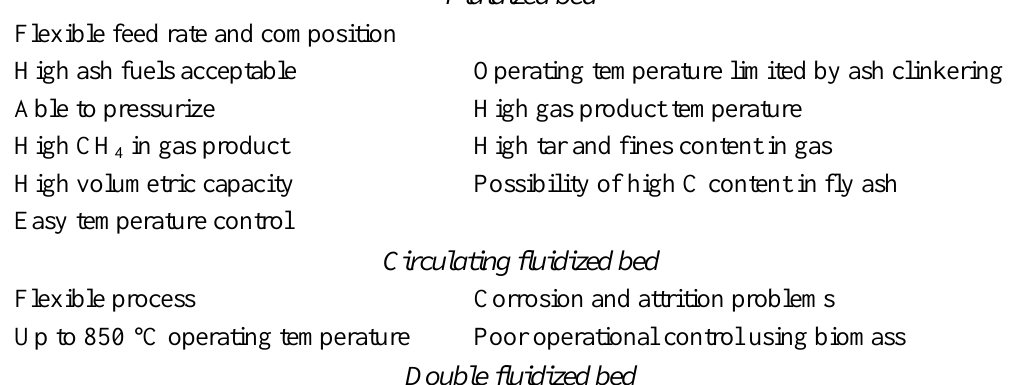
Table 2. Cont. Fluidized